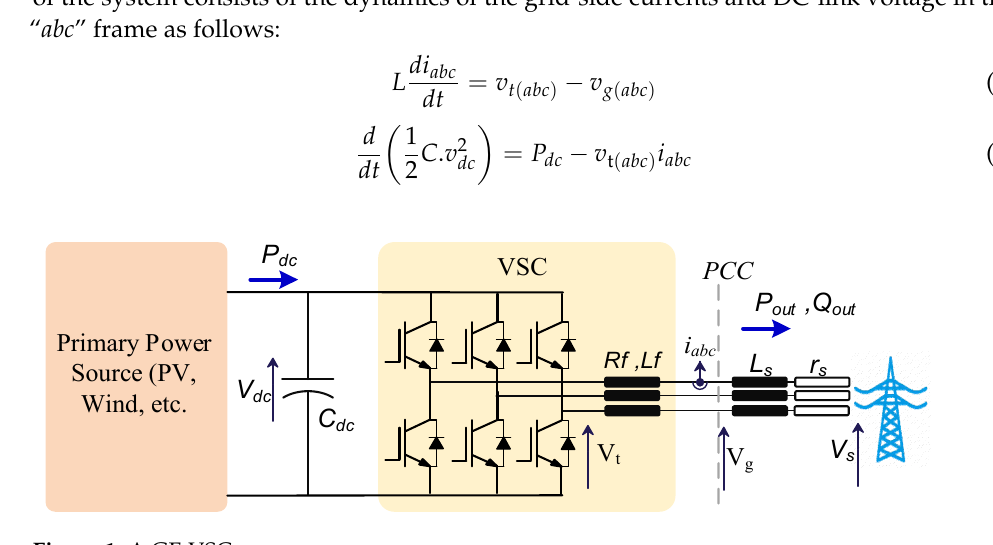
Figure 1. A GF-VSC. Figure 1. A